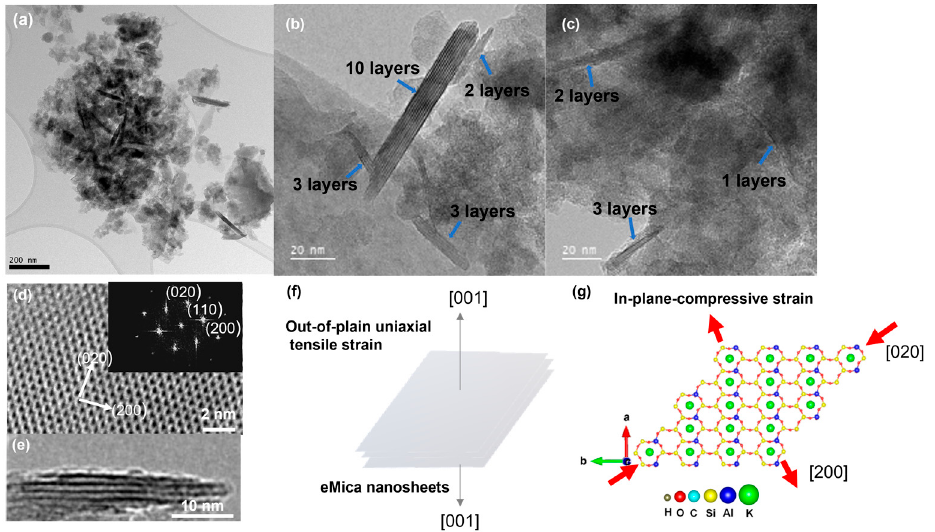
Figure 3. TEM images of eMica nanosheets at ( a ) low magnification, ( b ) moderate magnification, ( c ) high magnification and the view of the edge showing number of layers of nanosheets. HRTEM images of the ( d ) basal plane view of eMica nanosheets and the corresponding fast Fourier transform (FFT) image. ( e ) The cross-section HRTEM is along [001]. Diagram of ( f ) outer plane uniaxial tensile strain and ( g ) in-plane biaxial tensile and compressive strain in eMica nanosheets. In the planar orientation, lattice fringes with interplanar spacings of 2.65 Å, 4.43 Å, and 4.71 Å corresponding to the (200), (020), and (110) planes of the ditrigonal are revealed (Figure 3d, FFT image). The labelled (020) atomic plane spacings of the eMica nanosheets are ~1.8% smaller than the corresponding lattice spacings in bulk mica, consistent with the XRD results, indicating biaxial compressive strain (Figure 3g) in the basal plane along (020) and (200).